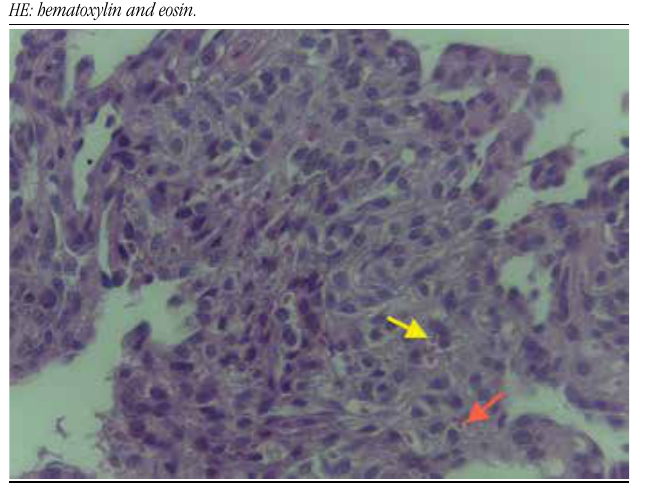
figuRE 5 − Blood vessels containing erythrocytes: arrow in red; erythrocytes surrounded by cells of epithelioid aspect: yellow arrow (HE, 400×) HE: hematoxylin and eosin.